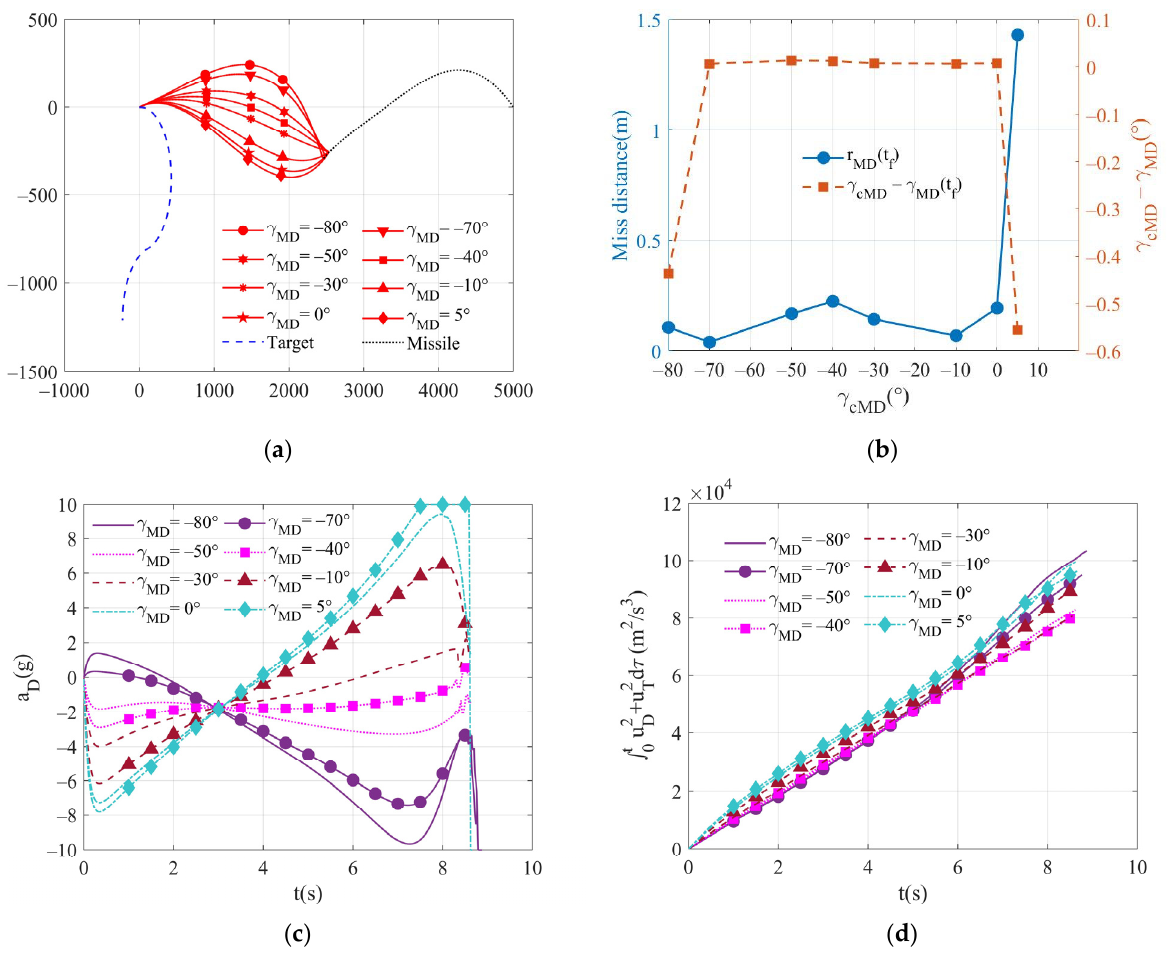
Figure 8. Comparison of performance for different terminal impact angle commands in one-way cooperation with an independent target: ( a ) trajectories of entities; ( b ) the terminal miss distance and terminal impact angle; ( c ) defender lateral acceleration; and ( d ) total control effort.